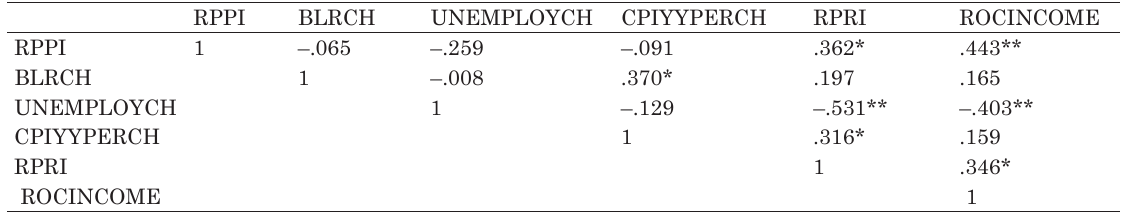
Table 1. Correlation between selected economic variables between January 2003 and June